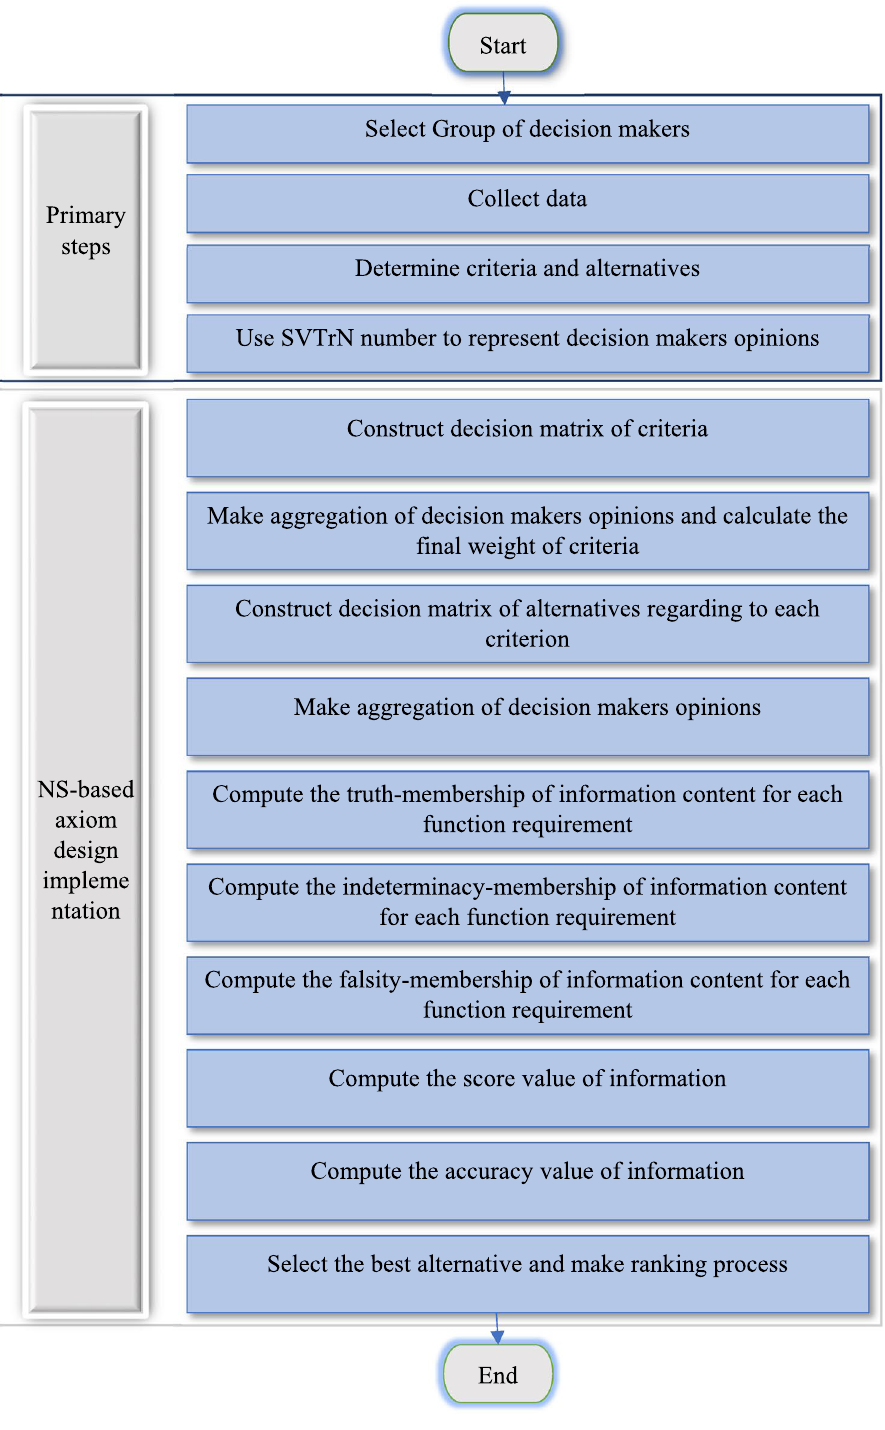
Figure 4. Flowchart of proposed